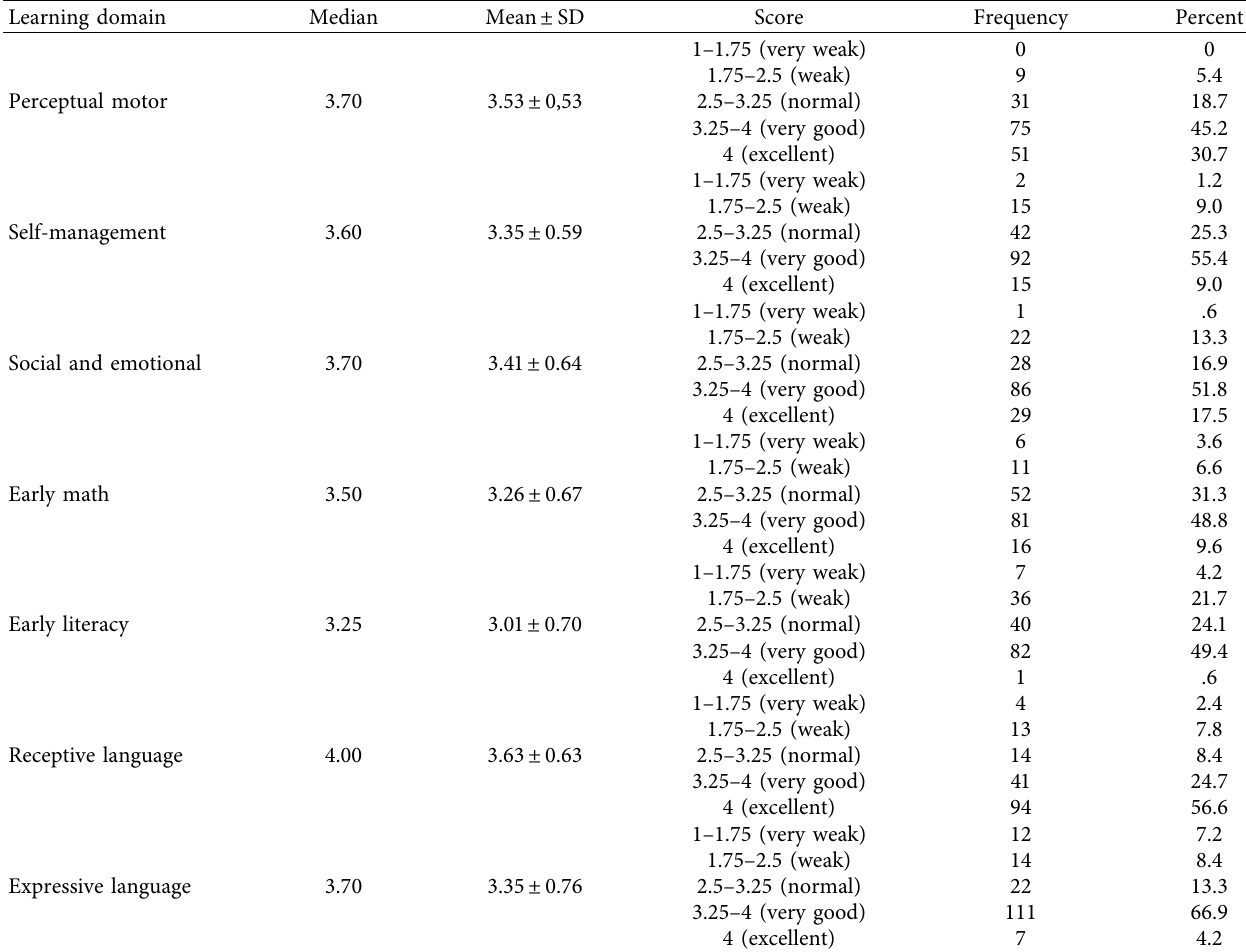
Table 8: Descriptive statistics and frequency distributions ( n �